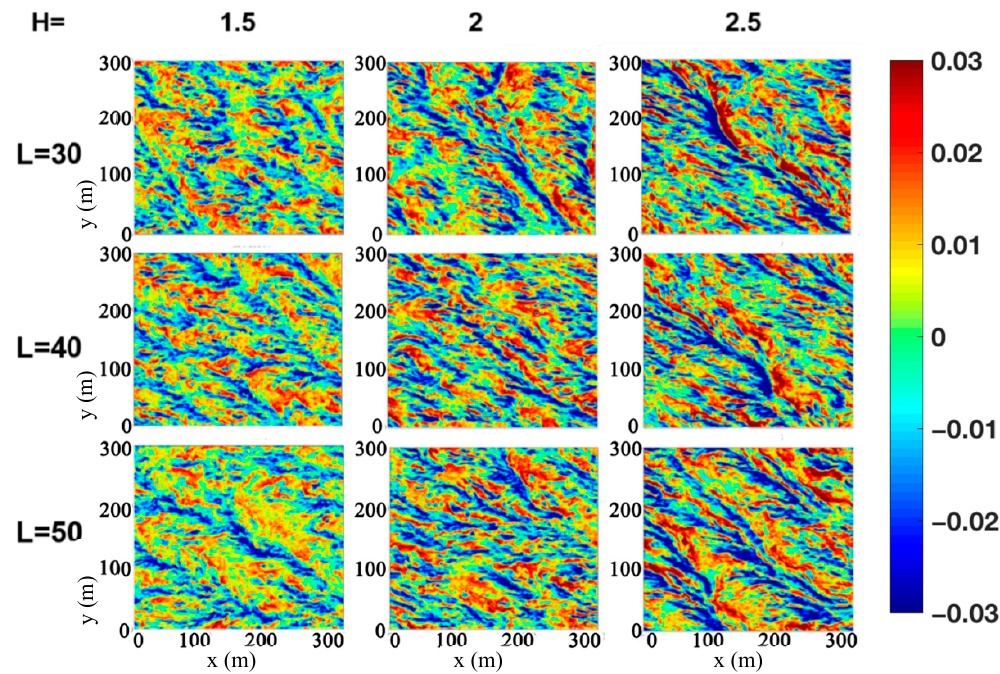
Figure 3. Horizontal cross-section of vertical velocity (m/s) (z = 8 m). The EXPLB with different values of 𝐿𝑎 (cid:3047) ( 𝐿𝑎 (cid:3047) = 0.30, 0.26, 0.23, 0.37, 0.32, 0.29, 0.44, 0.38, 0.34).